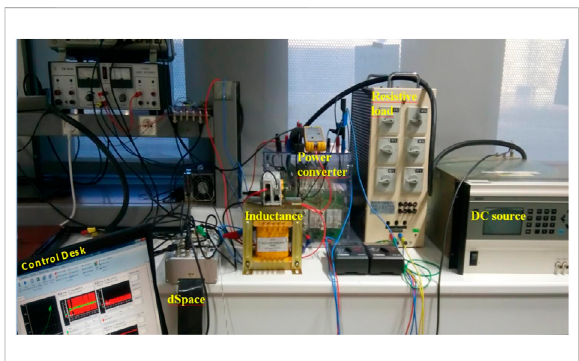
FIGURE 11 Laboratory experimental setup of the emulated PV